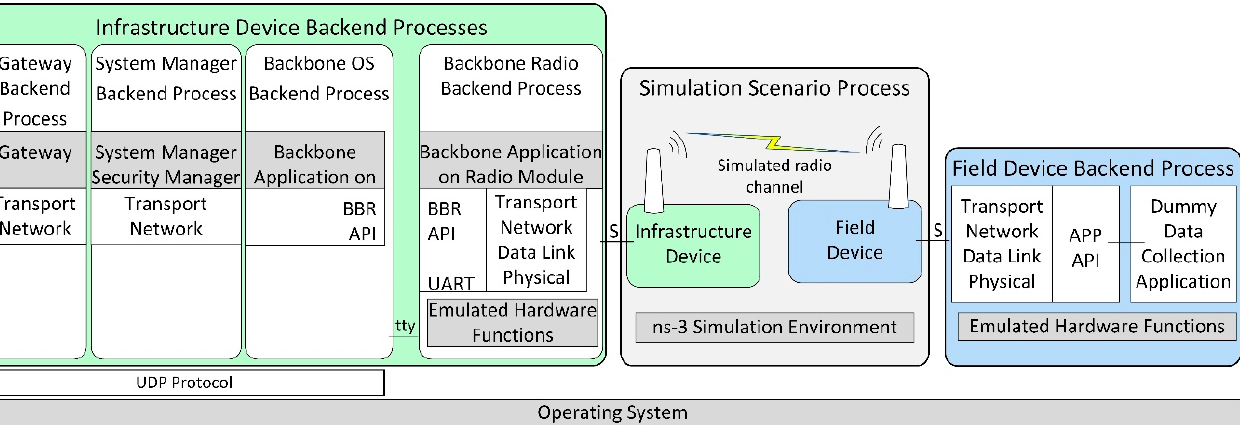
Figure 3. The architecture of the implemented ISA100.11a simulation model. The simulated infrastructure and field device models are formed by a set of backend processes that run inside the operating system (Ubuntu 18.04 Linux distribution) instead of running on dedicated